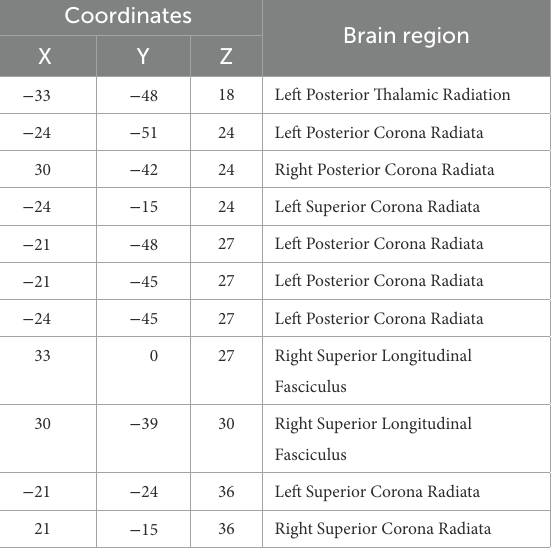
TABLE 4 White matter brain areas with significant differences between the PD and control groups based on the John Hopkins University-White Matter